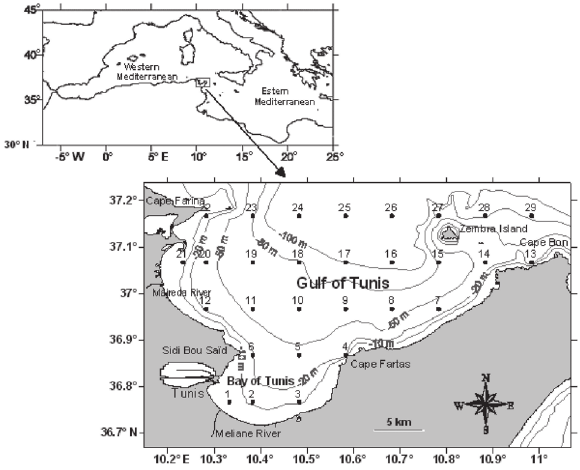
Fig. 1. – study area and location of the sampling